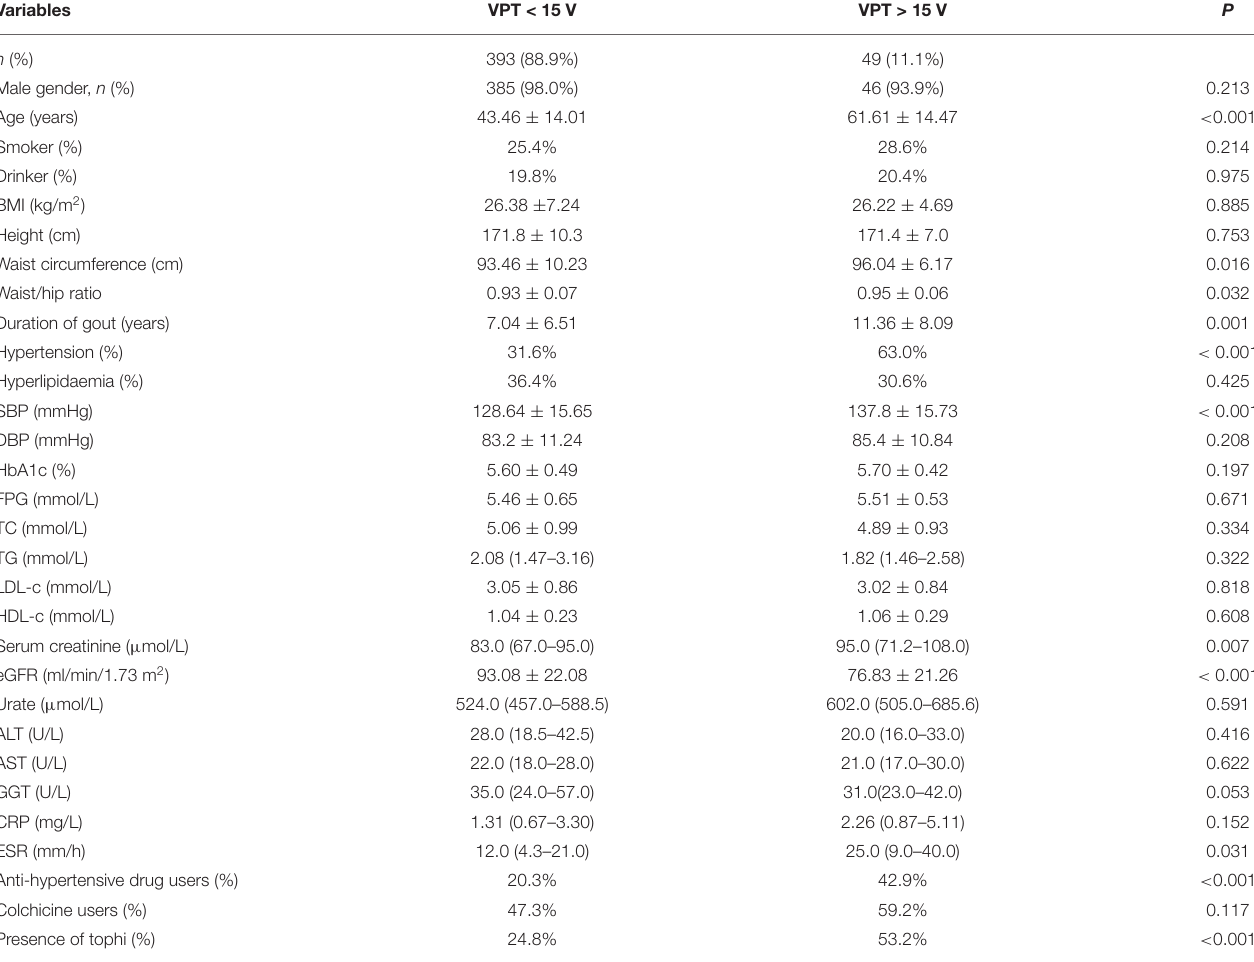
TABLE 1 | Clinical characteristics of patients with gout according to the vibration perception threshold (VPT) (voltage) stages ( n = 442).